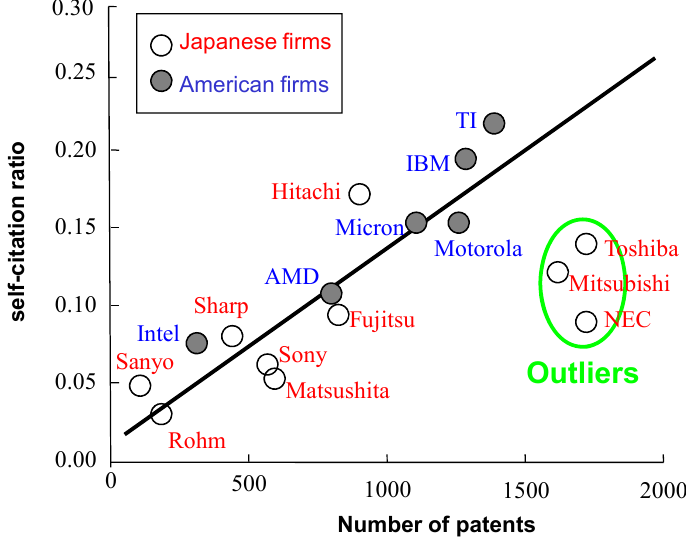
Figure 2. The relationship between the number of patents and the self-citation